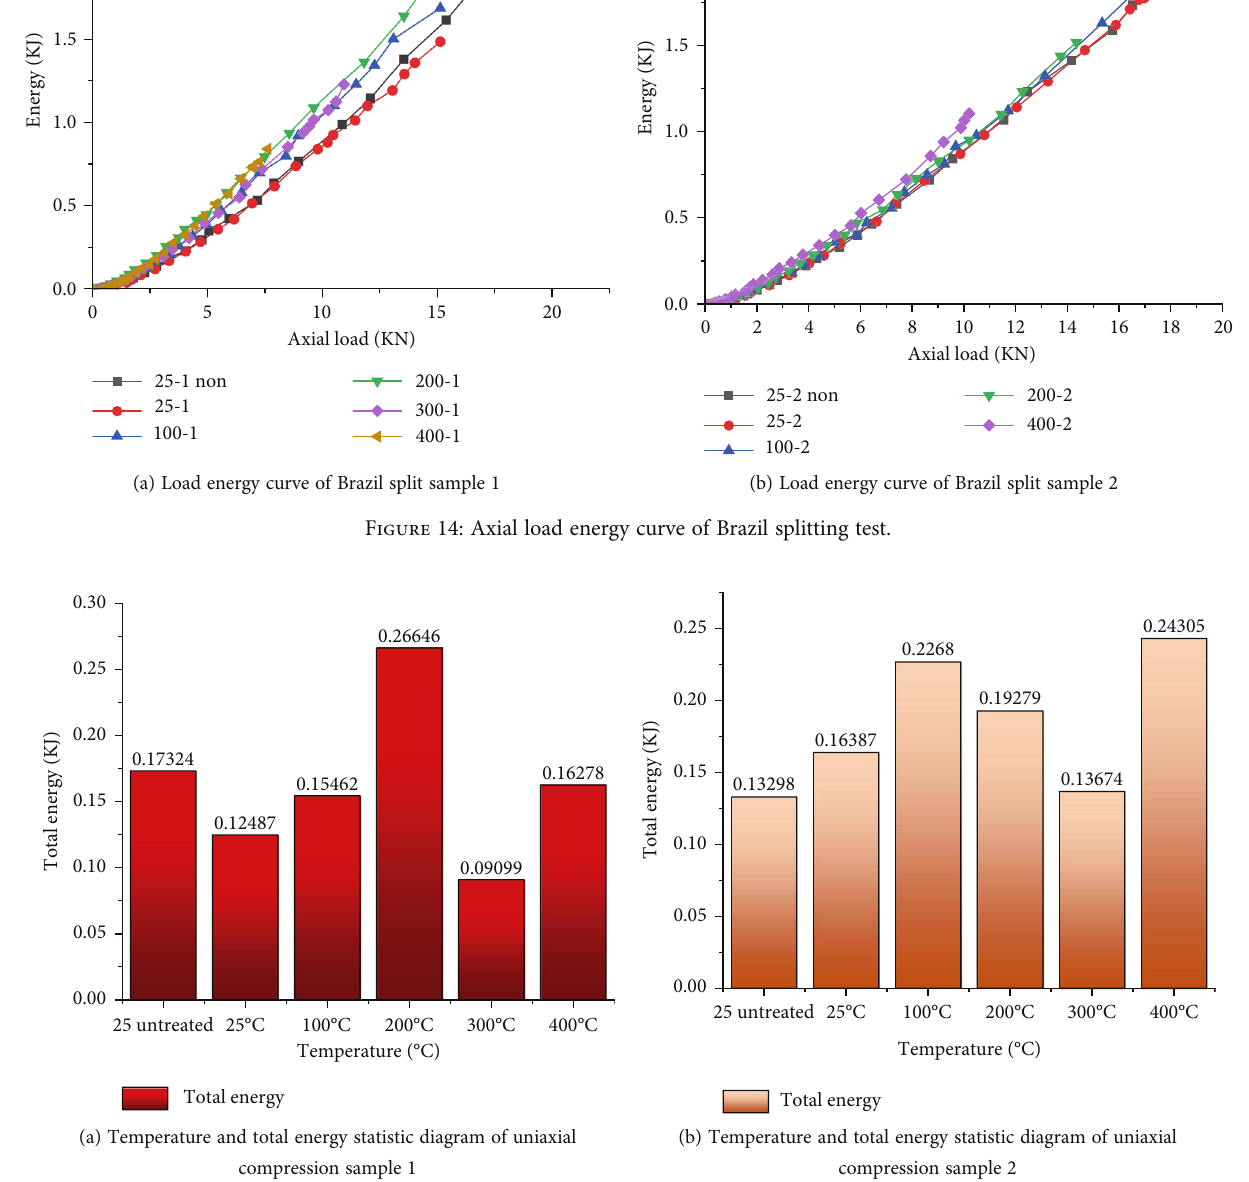
Figure 15: Temperature and total energy statistics of uniaxial compression